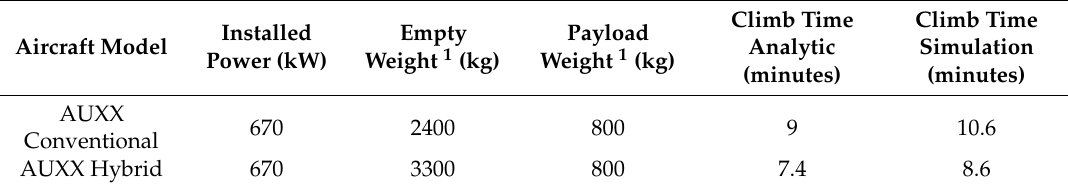
Table 3. Calculated and simulated climb